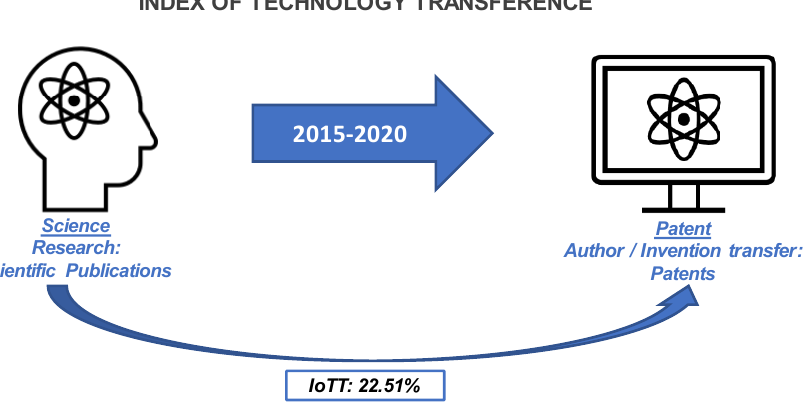
Figure 4. Index of Technology Transference (IoTT): Percentage of transfer between Science and Patent between the Period: 2015 – 2020.